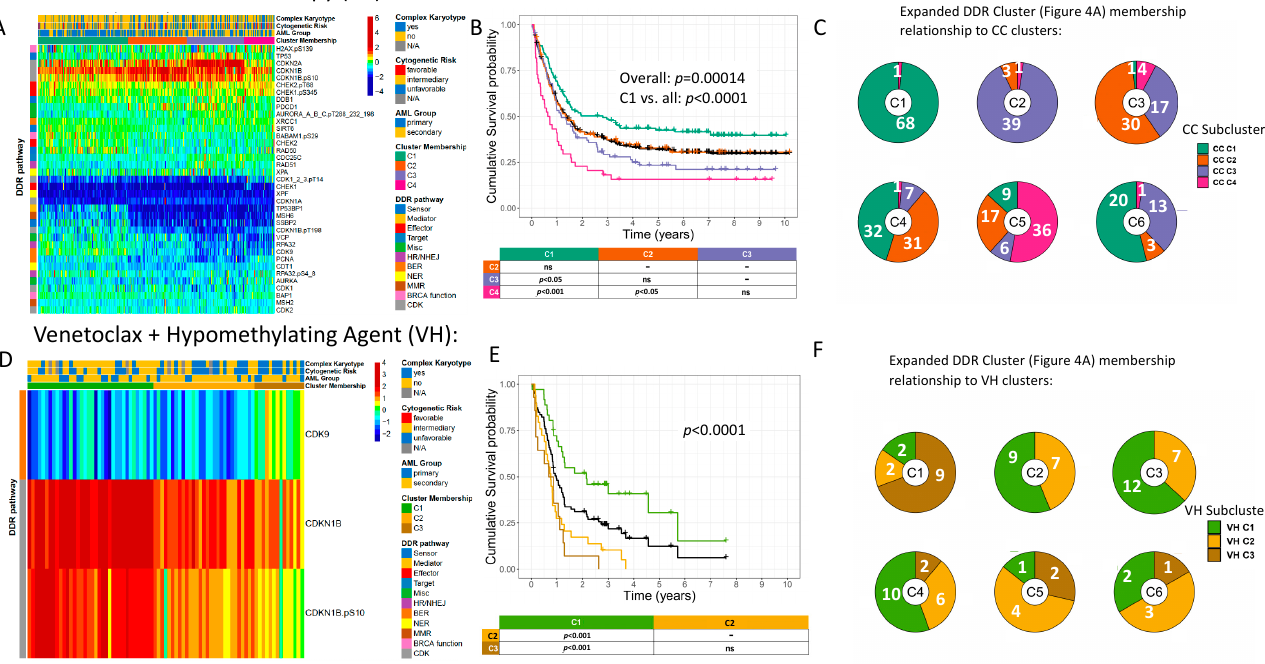
Figure 5. DDR and DDR-related protein groupings are prognostic for overall survival in CC and VH patients. The expanded set of DDR and DDR-related proteins (ExpDDR) was combined with additional DDR-related proteins [29] to constitute a maximally expanded array of relevant proteins involved in DDR. ( A ) Among those patients treated with conventional chemotherapy (CC), this maximally expanded protein grouping identified four patient clusters with distinct DDR expression patterns, as shown in the heatmap. The heatmap itself displays the expression levels of these DDR- related proteins in all patients. Proteins downregulated in expression relative to normal CD34+ cells are colored in cooler colors approaching deep blue, while upregulated proteins are colored in warmer colors approaching burgundy. ( B ) Associated OS curves ( n = 340) for CC patients stratified by the same four clusters identified in the heatmap. ( C ) Pie charts show the proportion of these four clusters represented in each of the six clusters identified by the ExpDDR grouping in Figure 4A. ( D ) A subgroup of three proteins from the maximally expanded set of DDR and DDR-related proteins was prognostic for OS among patients treated with venetoclax and a hypomethylating agent. The heatmap is derived from three DDR-related proteins, CDK9, CDKN1B, and CDKN1B.pS10, and identifies three clusters of patients. ( E ) Associated OS for these three clusters ( n = 79). ( F ) Expanded DDR Cluster (Figure 4A) membership relationship to VH clusters. When analyzed in conjunction with panel ( C ), the pie charts collectively identify which of the six ExpDDR clusters contain noticeable differences in outcome if patients were treated with CC vs. VH. ns = not